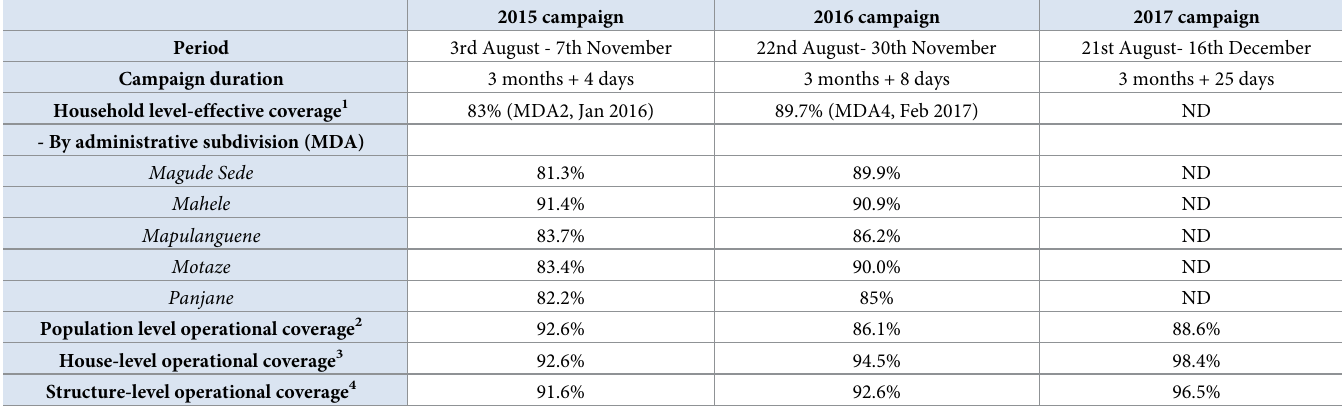
Table 3. Coverage and duration of the IRS campaigns implemented during the Magude